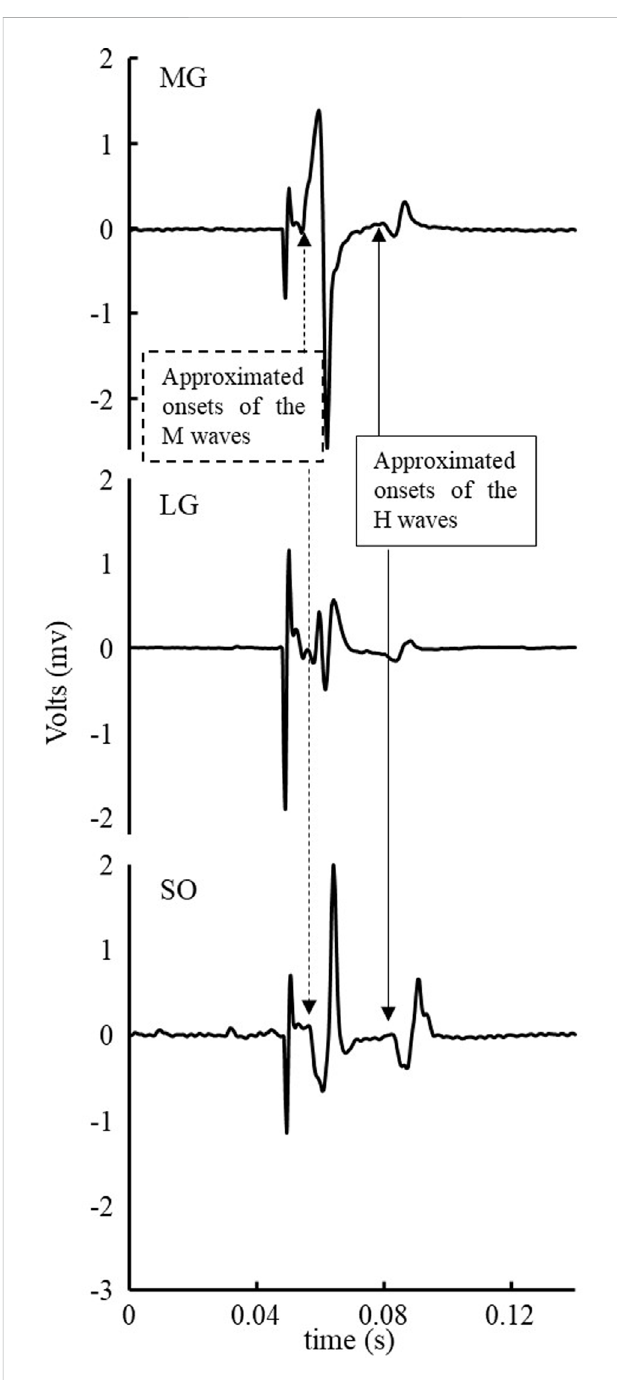
FIGURE 1 Exemplar EMG signal of a stimulus of triceps surae muscles within 50 milliseconds before the start of stimulus and after the end of the